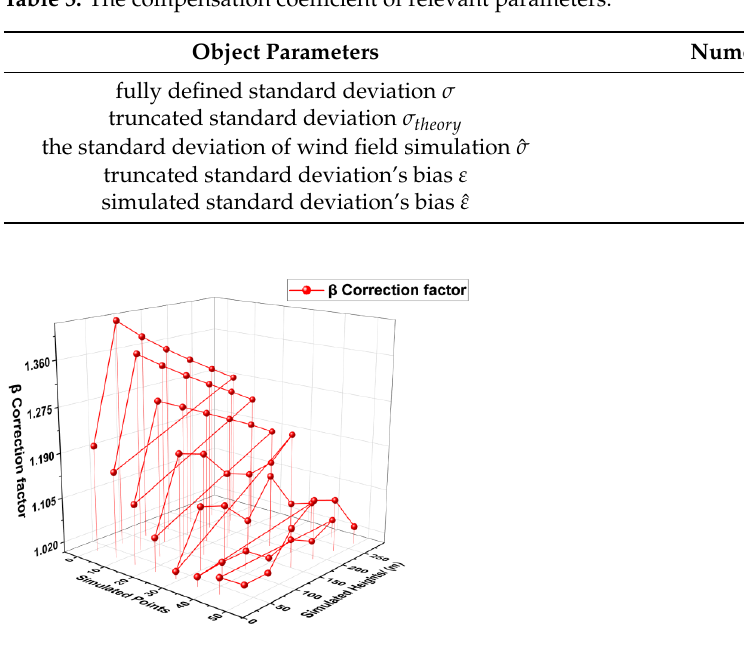
Figure 5. The distribution of correction factor of simulated points for two-dimensional space.